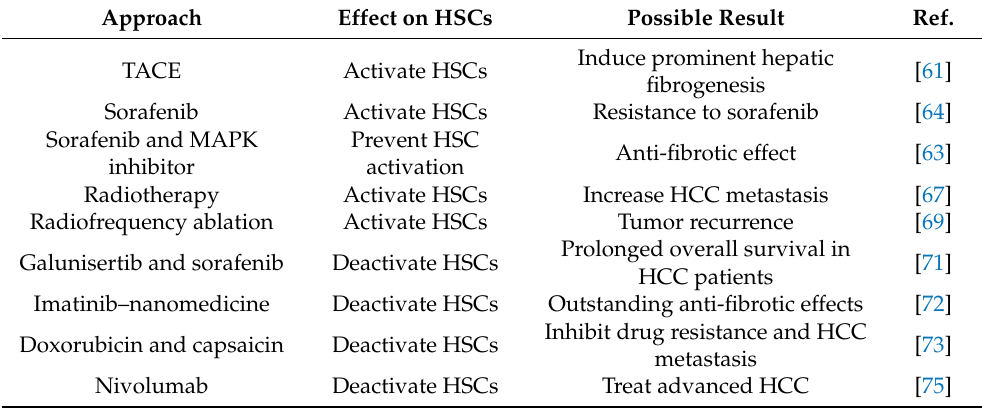
Table 2. Illustration of the effect of current treatments and new pharmacological studies on HSCs.